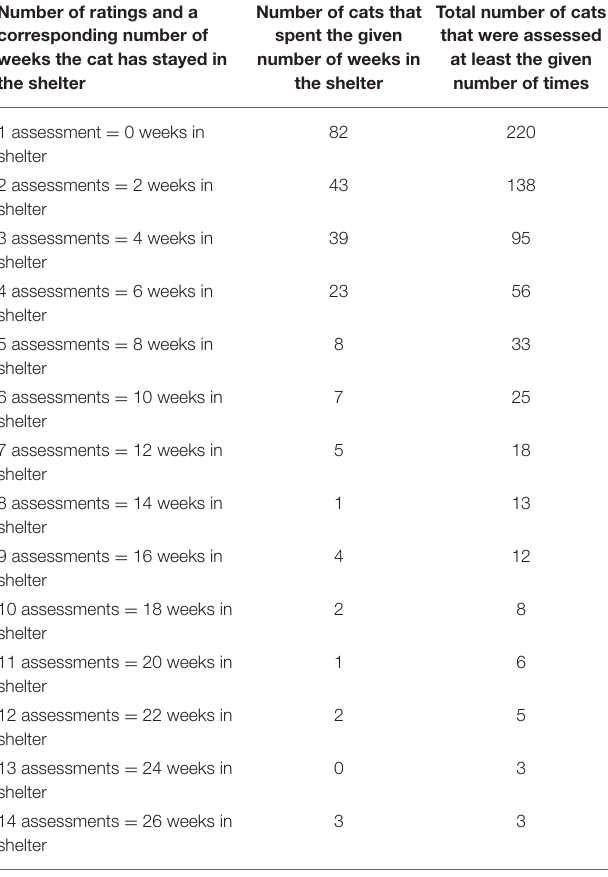
TABLE 2 | Number of cats assessed in the shelter during each week of assessment. Number of ratings and a corresponding number of weeks the cat has stayed in the shelter